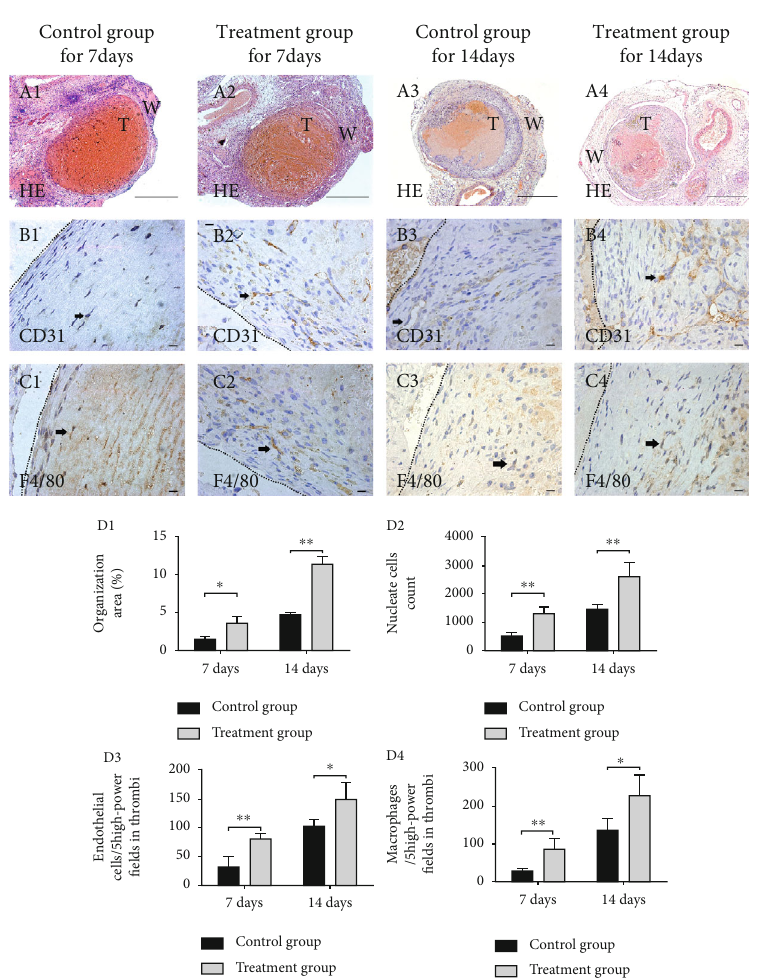
Figure 5: The organization and neovascularization of thrombi in control and treatment groups at postoperative days 7 and 14 ( n = 6 ). T indicates thrombus, and the black arrow indicates positive cells. A1 – A4, The HE staining, and A indicates artery. B1 – B4, Immunohistochemical staining with CD31 antibody. C1 – C4, Immunohistochemical staining with F4/80 antibody. As venous thrombi organization progressed, the monocytes and the endothelial cells entered into the thrombus, wherein the neovascularization appeared. D1 – D4, The organization area, thrombus cell counts, the number of endothelial cells, and macrophages in control and treatment groups, respectively. ∗ Signi fi cant di ff erences between control and treatment group, P < 0 : 05 . ∗∗ Signi fi cant di ff erences between control and treatment group, P < 0 : 01 . T: area of thrombi; W: area of vein wall. Scale bars: 100 μ m (A1 – A4); 15 μ m (B1 – C4). Magni fi cation: 40x (A1